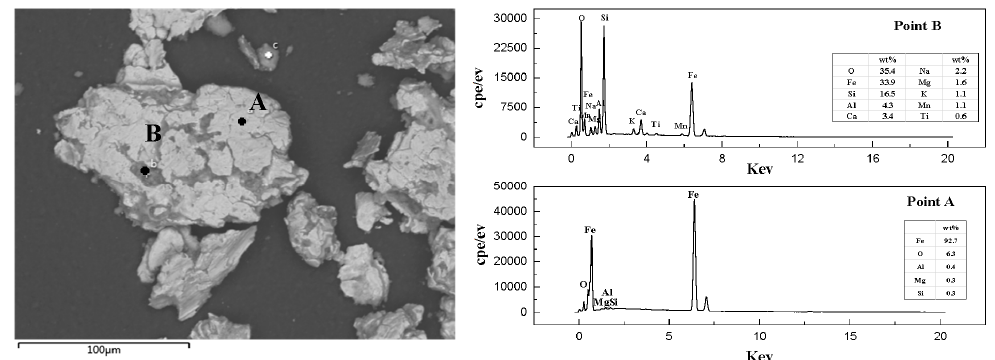
Figure 9. Scanning electron microscope with energy dispersion system (SEM-EDS) of the magnetic concentrate under the optimum condition (borax dosage of 5%, reducing at 1050 °C for 80 min, and grinding fineness (<0.044 mm) exceeding 81%).